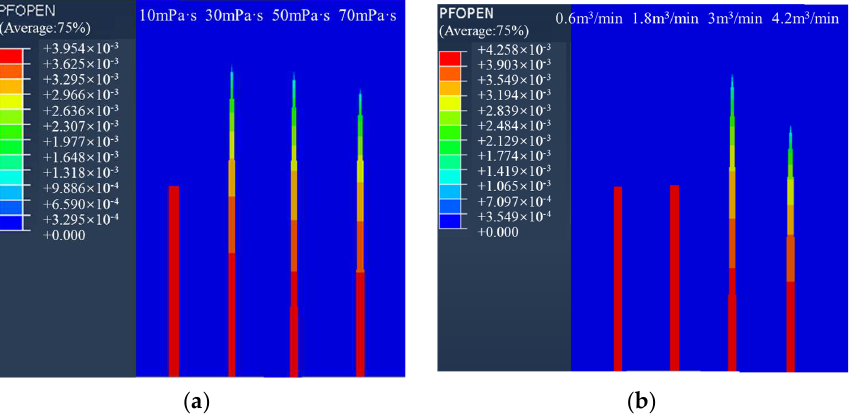
Figure 6. Numerical simulation results under different construction parameters: ( a ) Viscosity; ( b ) Displacement.